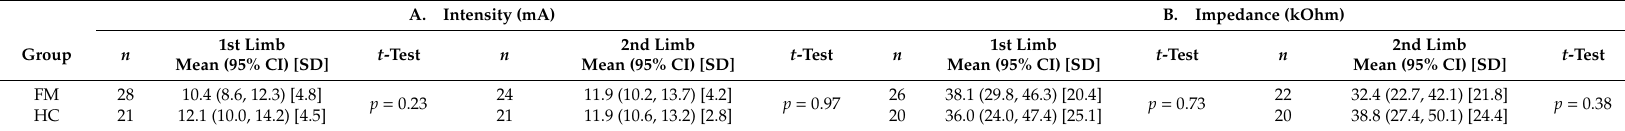
Table 4. Electrical stimulus